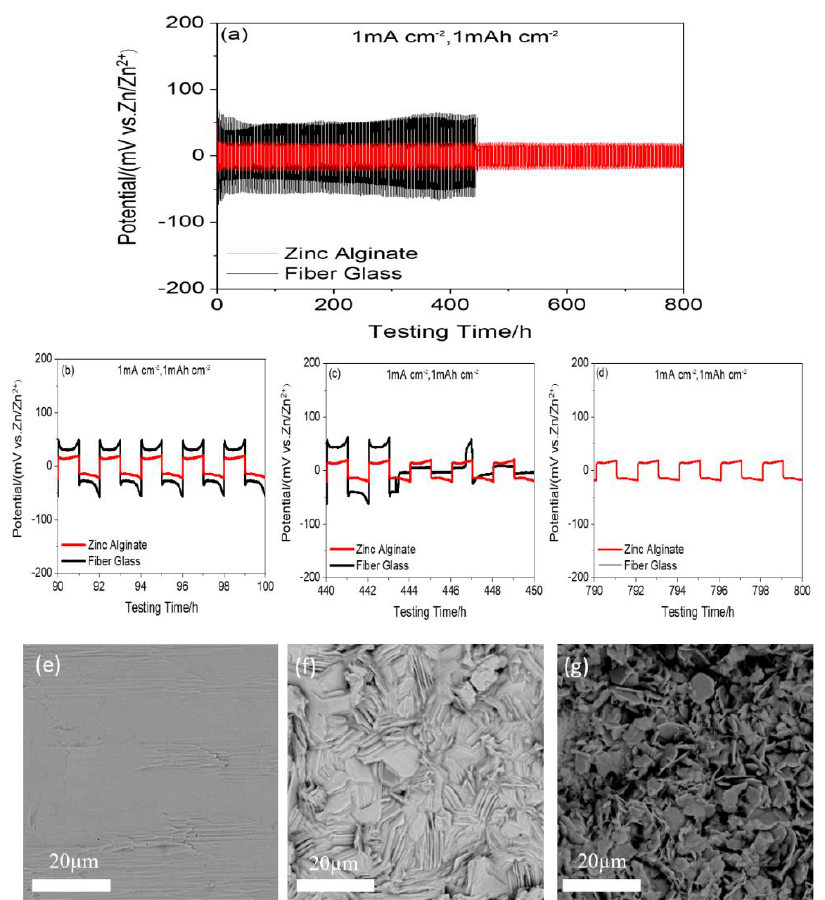
Figure 7. Electrochemical performance of Zn/ZA-based HGPE/Zn and Zn/wet glass-fiber separa- tor/Zn symmetrical cells: ( a ) Zinc-ion plating/stripping voltage profiles of two symmetric cells at a current density of 1 mA cm − 2 and a capacity of 1 mAh cm − 2 . Detailed plating/stripping voltage profiles at the ( b ) 90th–100th, ( c ) 440th–450th cycles, and ( d ) 790th–800th cycles. The SEM image of ( e ) the pristine Zn electrode and the Zn metal surfaces after 400 cycles in ( f ) Zn/ZA-based HGPE/Zn and ( g ) Zn/wet glass fiber separator/Zn cells.